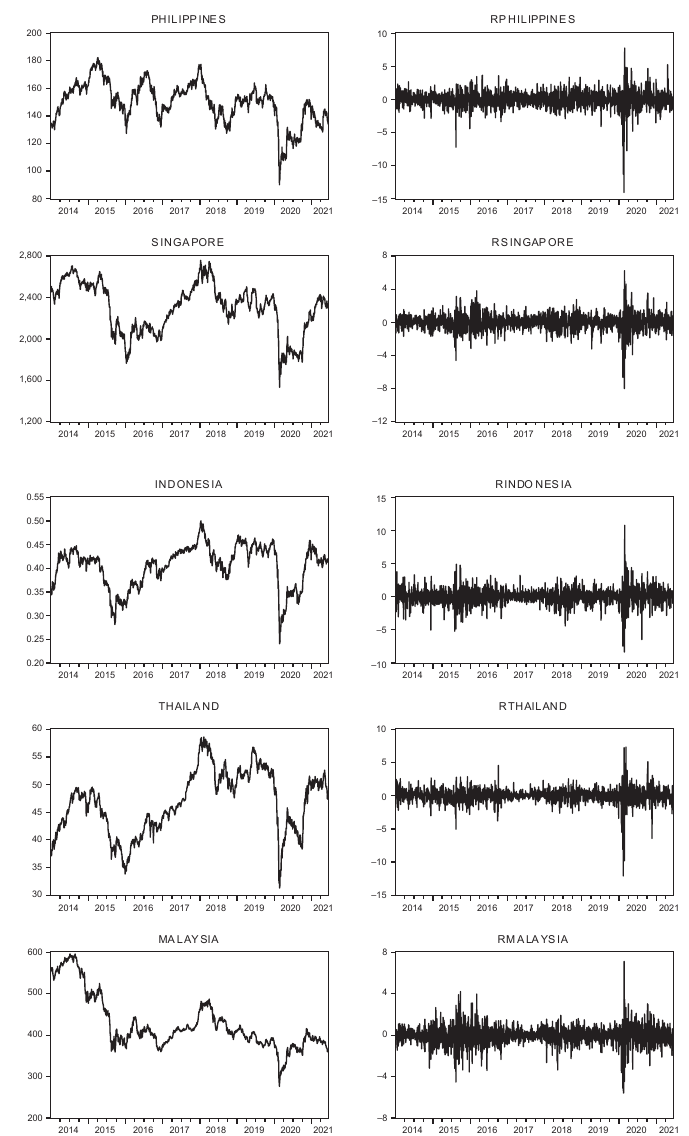
Figure 2. Daily prices and logarithmic stock index returns for Asian emerging